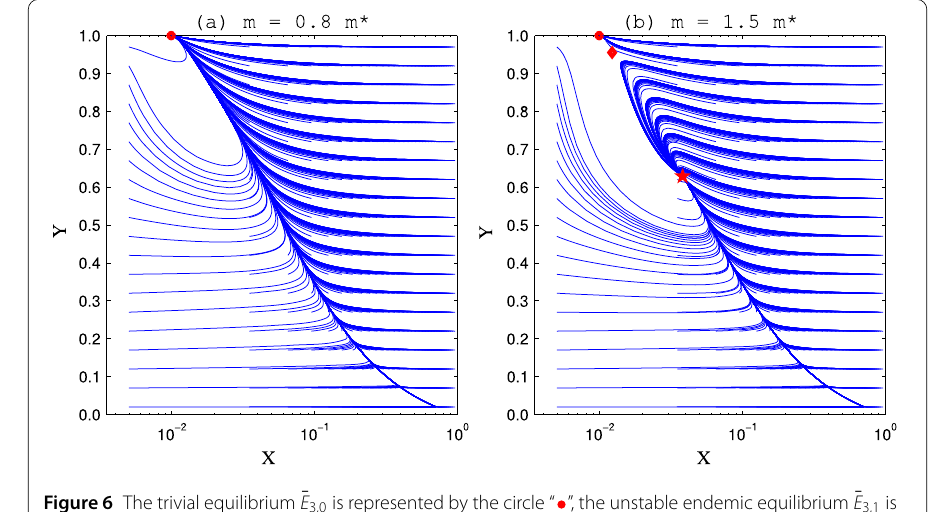
Figure 6 The trivial equilibrium ¯ E 3,0 is represented by the circle “ ”, the unstable endemic equilibrium ¯ E 3,1 is denoted by the rhombus “ ”, and the stable endemic equilibrium ¯ E 3,2 is represented by the star “ ”. Simulations have been done with parameter values λ = 10, μ = 0.1, β = 0.5, γ = 0.1, and h = 30. Part ( a ) is produced with m = 0.8 m (cid:6) , while part ( b ) is produced with m = 1.5 m (cid:6)